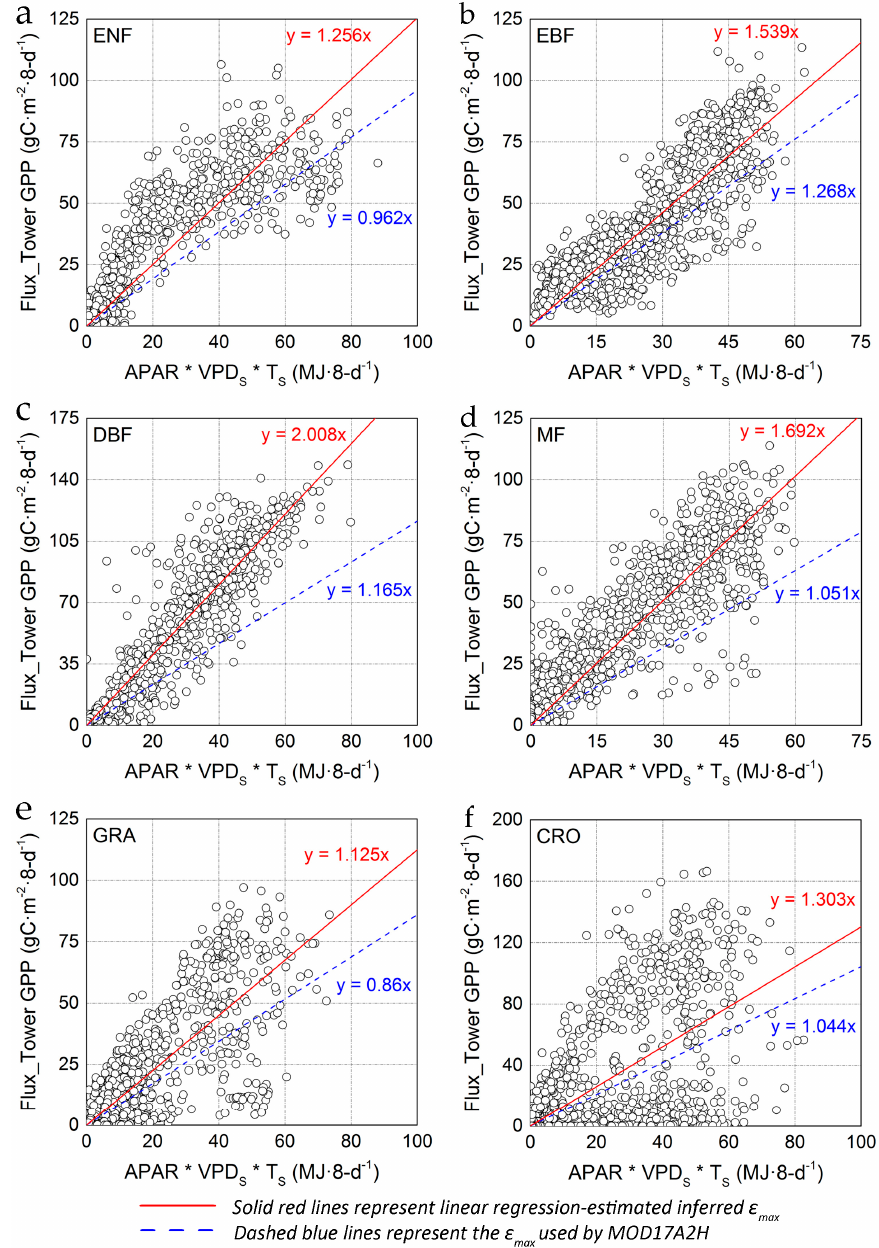
Figure 7. Eight-day site estimated GPP (gC·m − 2 ·8-d − 1 ) against the product of GLASS FPAR, tower PAR, VPD s and T s for ( a ) ENF, ( b ) EBF, ( c ) DBF, ( d ) MF, ( e ) GRA and ( f ) CRO. APAR (absorbed photosynthetic-active radiation) = FPAR × PAR.